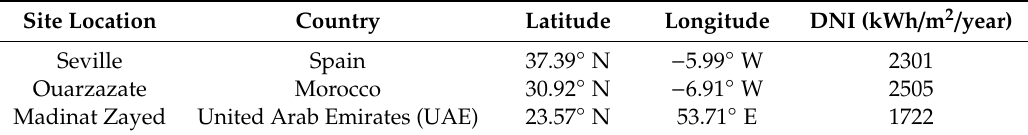
Table 7. Geographical coordinates and reference DNI of selected site locations.